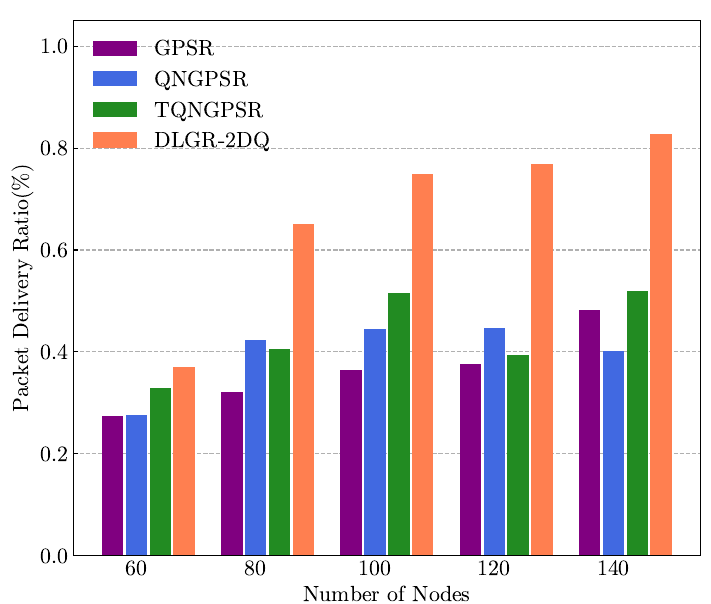
Figure 8. The effects of network density on